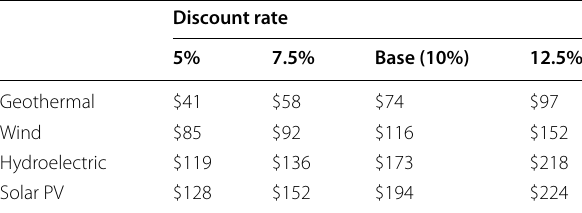
Table 2 Optimal trigger prices of coal at various